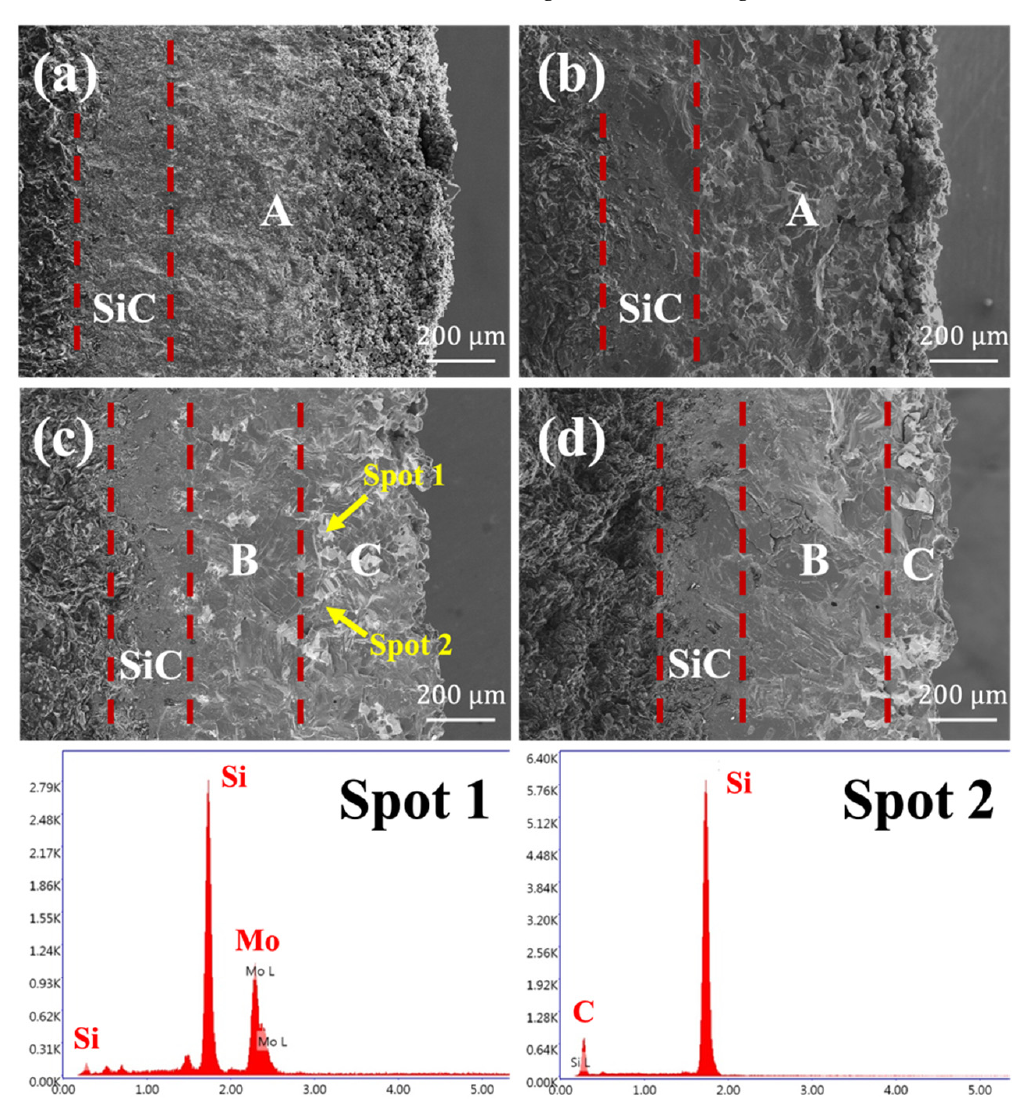
Figure 3. SEM images of the cross-section of SiC/MoSi 2 -SiC-Si coatings with different Si/Mo ratio: ( a ) 1:1, ( b ) 3:1, ( c ) 5:1, ( d ) 7:1.